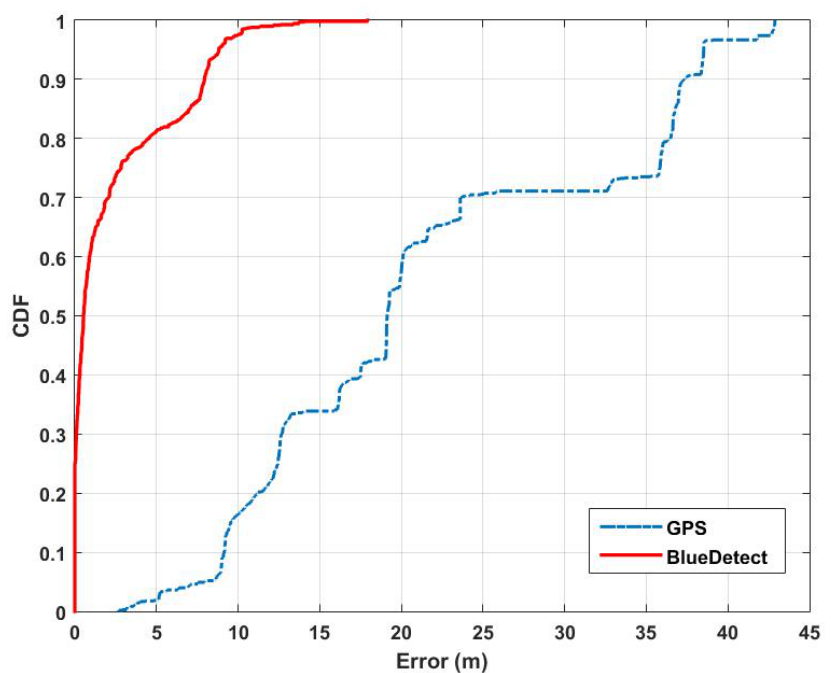
Figure 8. Comparison of the cumulative distribution of the location error between GPS and BlueDetect in semi-outdoor